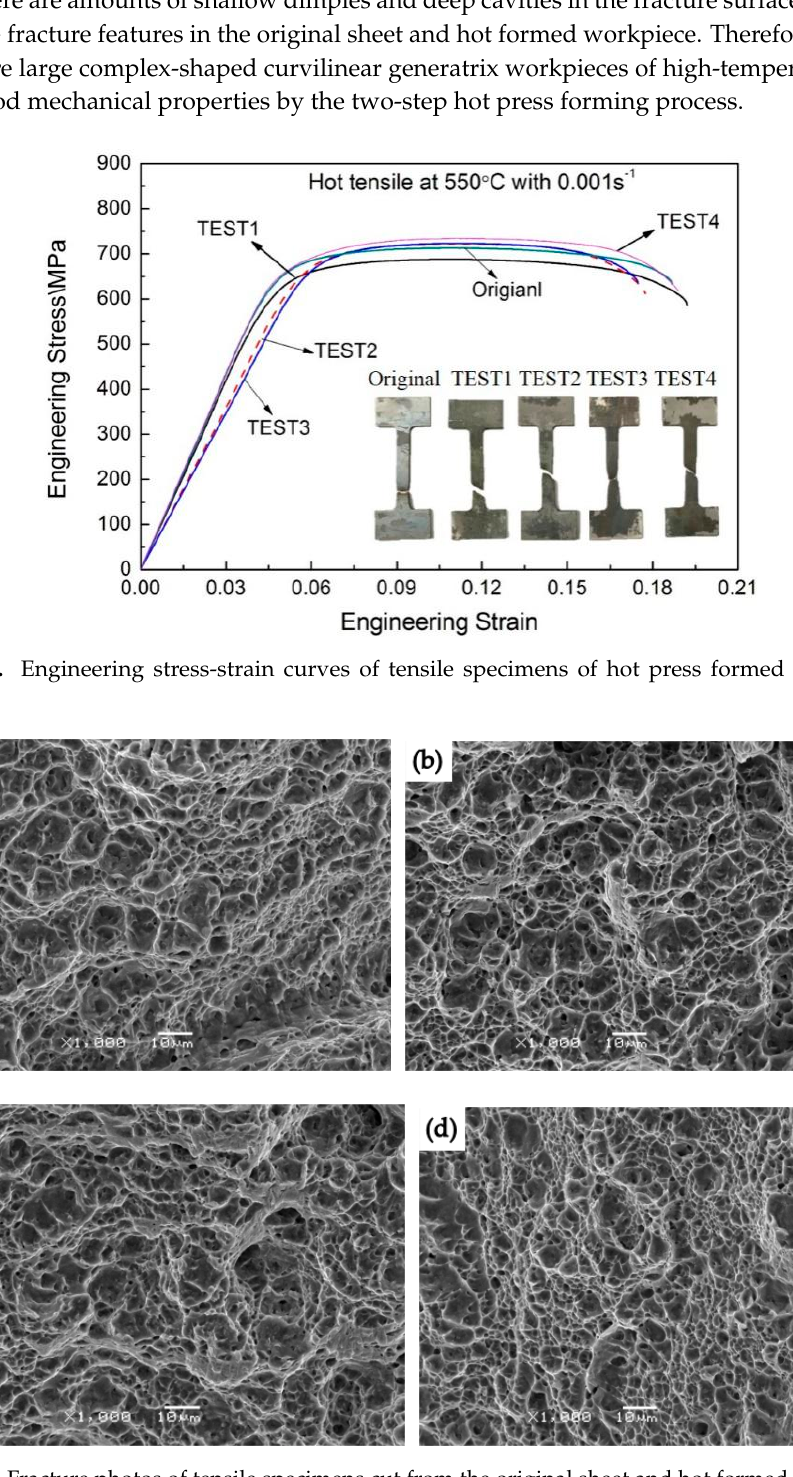
Figure 17. Fracture photos of tensile specimens cut from the original sheet and hot formed workpiece: ( a ) Original sheet; ( b ) TEST1; ( c ) TEST2; ( d ) TEST3.